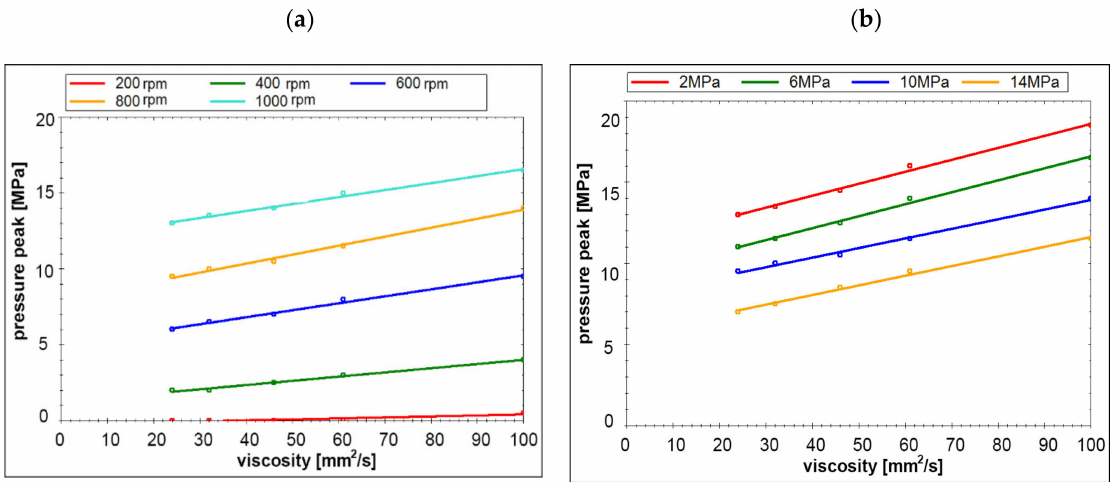
Figure 25. Influence of viscosity on pressure peaks value: ( a ) measured at a constant pumping pressure of 10 MPa, pump displacement set to 20% of the maximal value and a variable rotational speed; ( b ) measured at a constant rotational speed, pump displacement set to 20% of the maximal value and a variable pumping